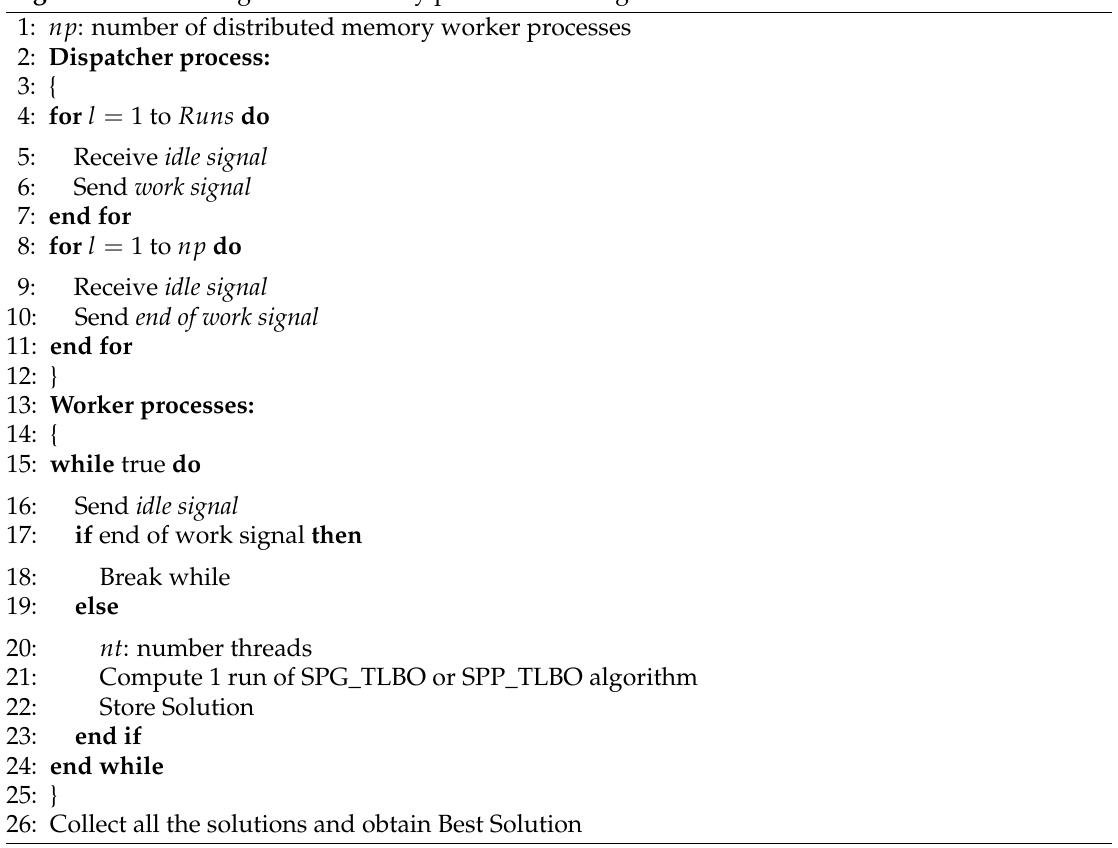
Algorithm 10 Heterogeneous memory parallel TLBO